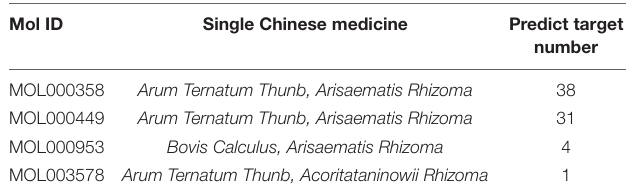
TABLE 2 | Single Chinese medicine with repeated